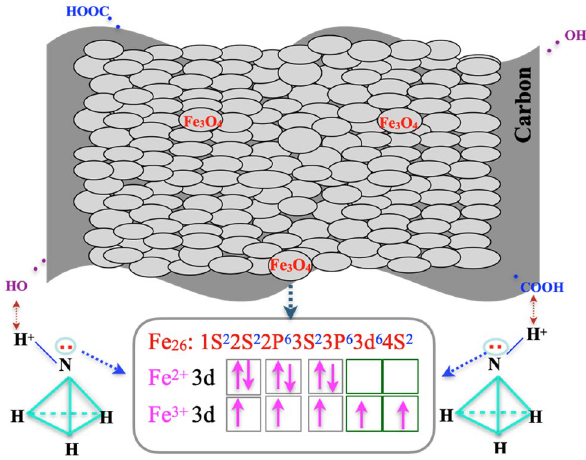
Figure 9. Schemata of the electronic structures of ammonium ion and iron oxide, and the electrostatic adsorption between NC and carbon ferrite.